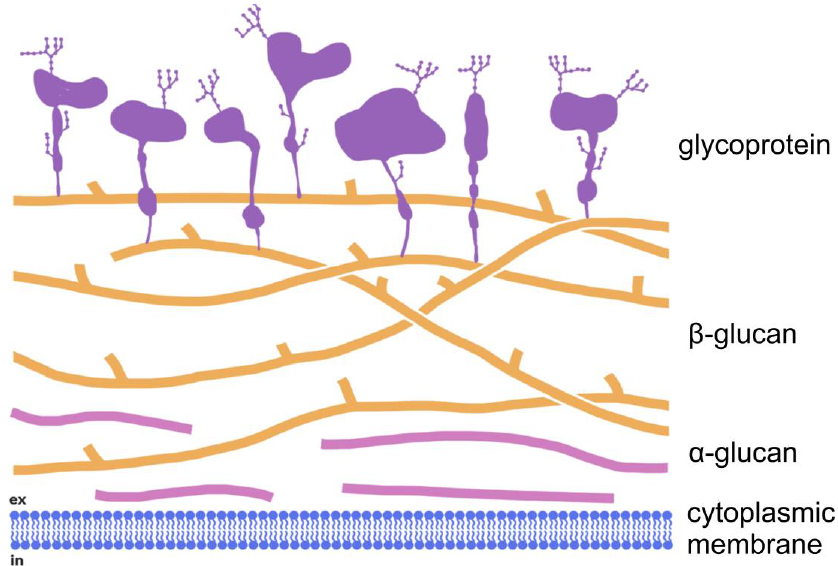
Figure 1. Structure of fungal cell walls by Grün [3].